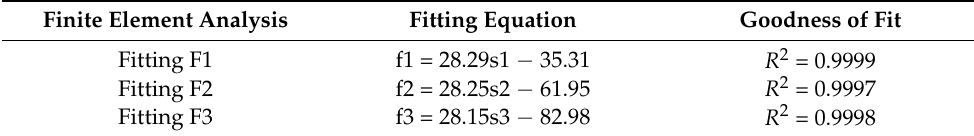
Figure 15. The relationship between impact force and stress response at three impact points. Table 2. The functional relationship of finite element analysis shock model. Finite Element Analysis